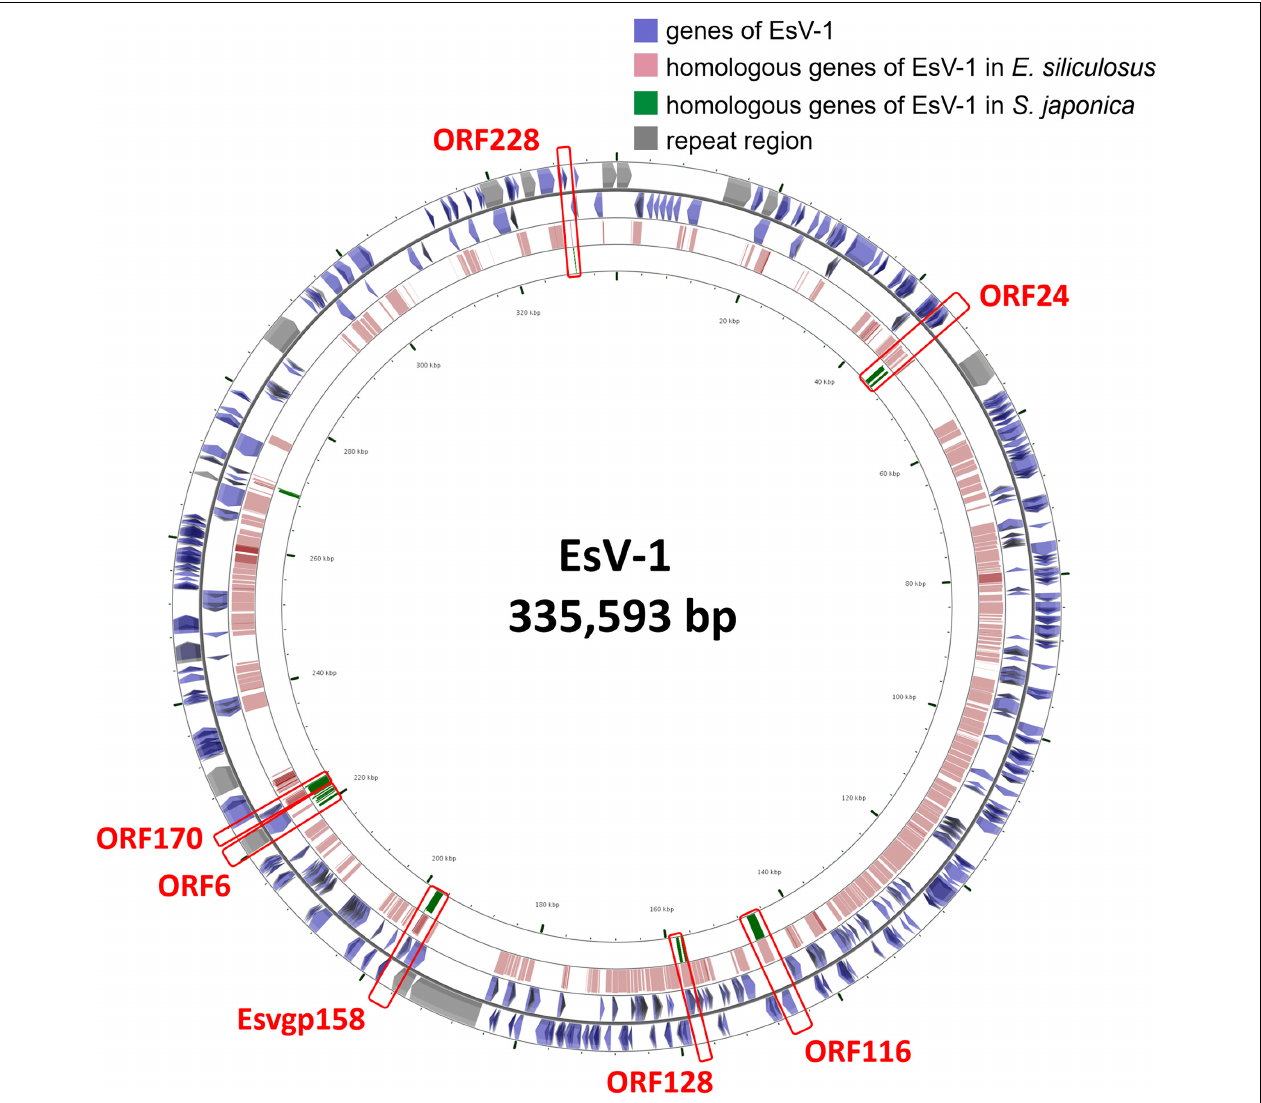
FIGURE 1 | The viral EsV-1 genome and its fragments integrated in the S. japonica and E. siliculosus genomes. The genes highlighted in red bar are found in both S. japonica and E. siliculosus genomes.